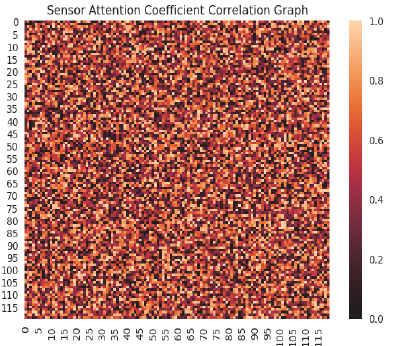
Figure 7. Sensor attention correlation coefficient heat map.